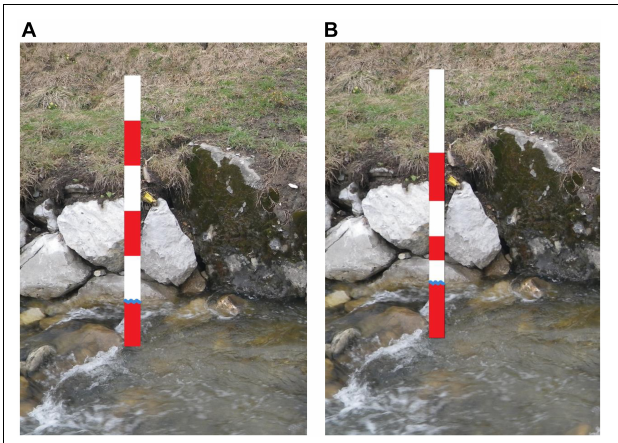
FIGURE 4 | Early version of the virtual staff gauge with regular (A) and irregular (B) class sizes.